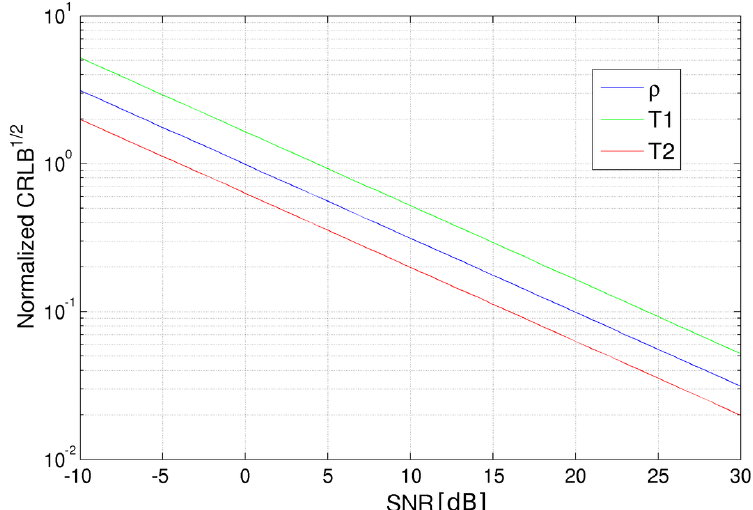
Figure 1. Square root of the Cramer–Rao lower bound (CRLB) for proton density (blue), spin-lattice ( T ) relaxation time (green) and spin-spin ( T ) relaxation time (red) for different 1 2 signal-to-noise ratio values expressed in decibels (logarithmic scale). CRLB values have been normalized for the parameter values in order to be plotted in the same